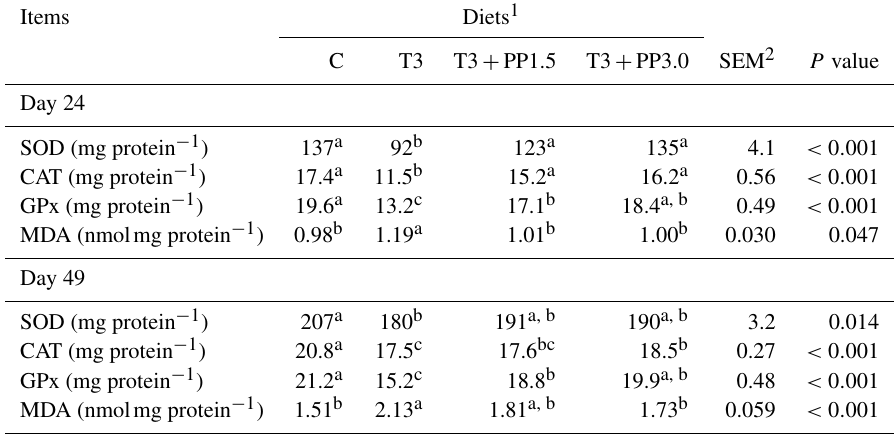
Table 6. Effects of dietary treatments on superoxide dismutase (SOD), catalase (CAT), and glutathione peroxidase (GPx) activities as well as malondialdehyde (MDA) concentrations of liver in broiler chickens at 24 and 49 days of experiment. Items Diets 1 C T3 T3 + PP1.5 T3 + PP3.0 SEM 2 P value Day 24 SOD (mg protein − 1 ) 137 a 92 b 123 a 135 a 4.1 < 0 . 001 CAT (mg protein − 1 ) 17.4 a 11.5 b 15.2 a 16.2 a 0.56 < 0 . 001 GPx (mg protein − 1 ) MDA (nmolmg protein − 1 ) Day 49 SOD (mg protein − 1 ) 207 a 180 b 191 a, b CAT (mg protein − 1 ) GPx (mg protein − 1